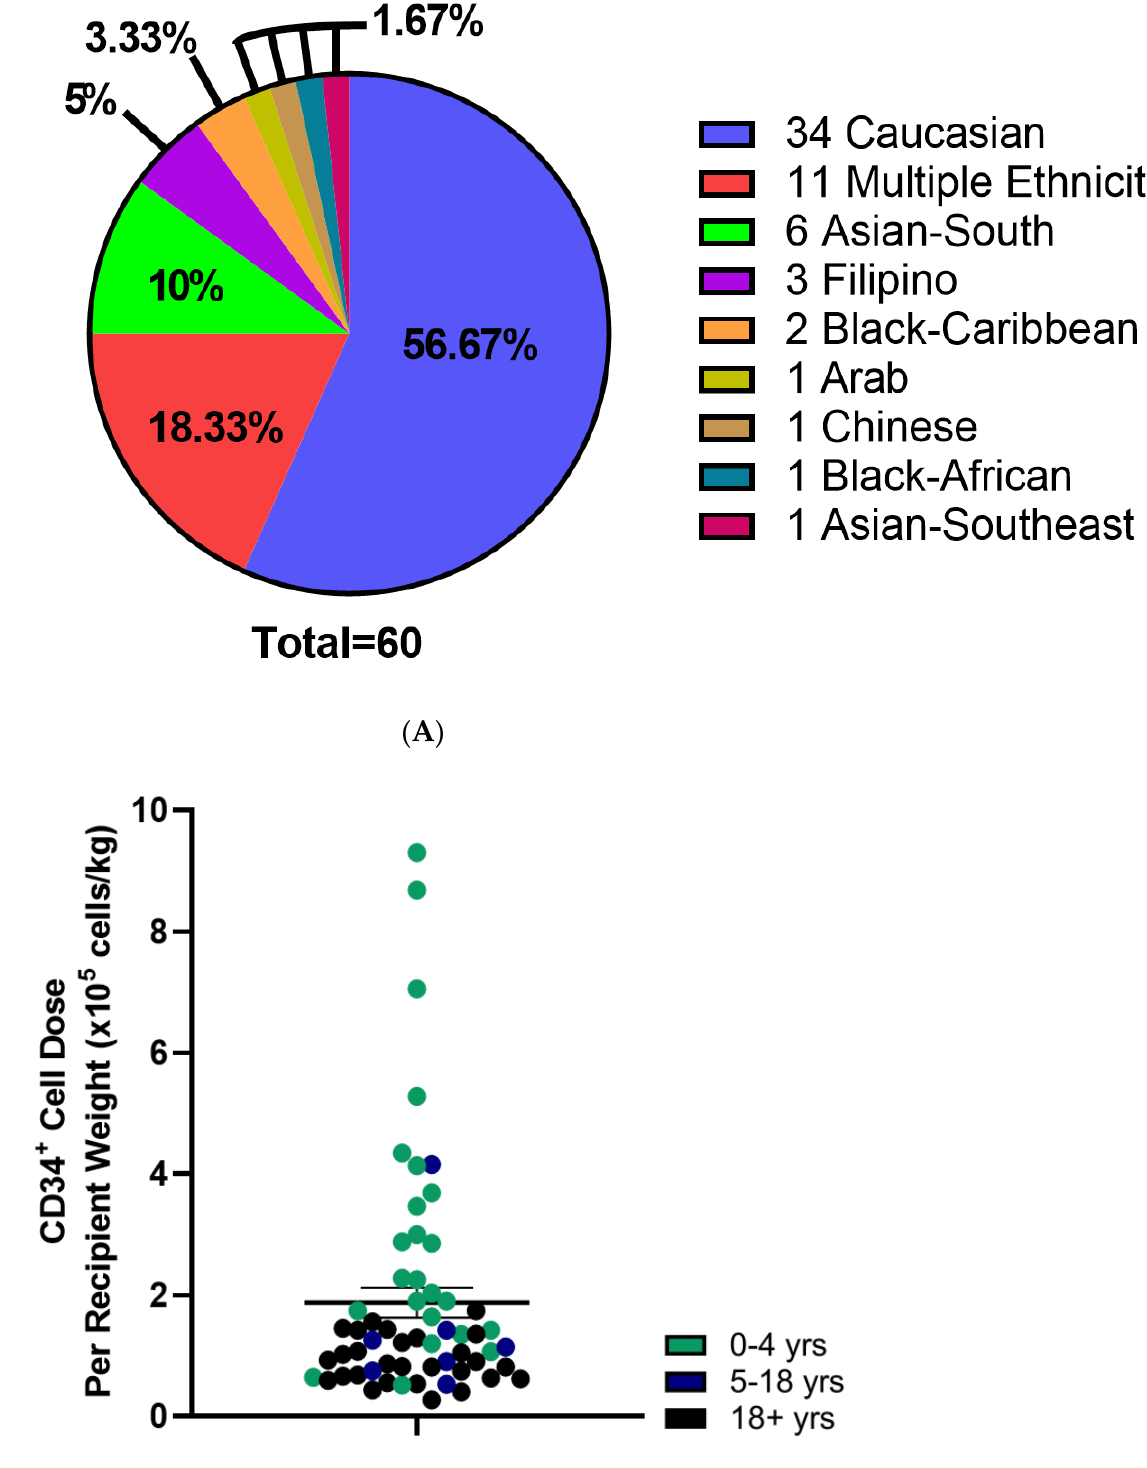
Figure 3. Characteristics of Distributed Cord Blood Units. ( A ) Self reported Ethnicity of distributed CBUs. ( B ) CD34 + cell dose per kg recipient weight of distributed CBUs. Patient age indicated with color. N = 59. Means indicated ± SEM.